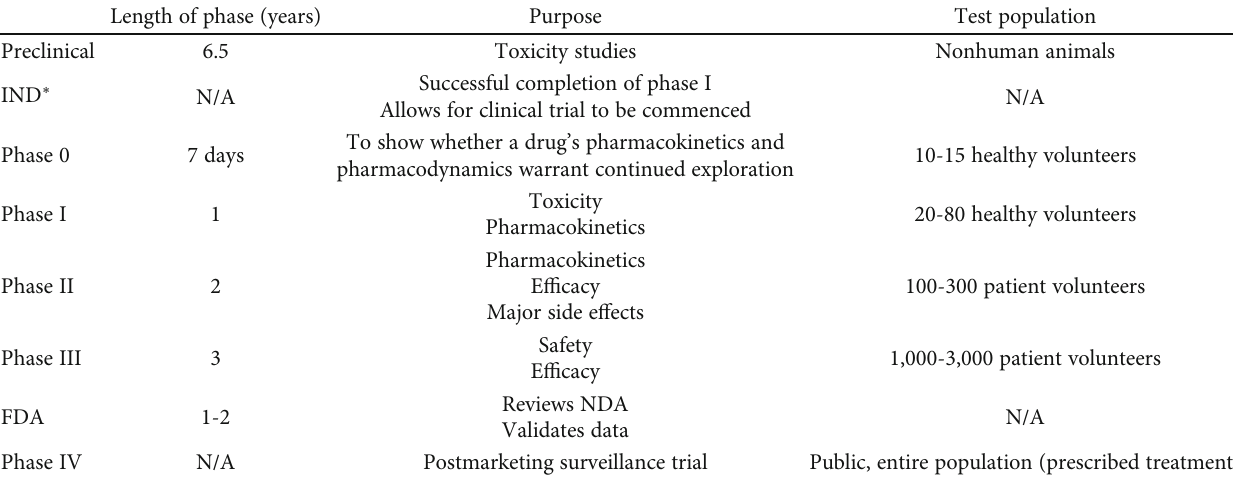
Figure 1: The challenges of treating CNS disorders. Both subjective and objective hurdles must be surpassed when developing pharmaceuticals for the treatment of CNS disorders and diseases. Overcoming these hurdles has proven di ffi cult leading to a minimum an increase in time and cost for drug development and at a worse to many drug failures that would otherwise be realized for a systemic- related disorder. Table 1: Clinical trial phases as regulated by the FDA. Table detailing FDA-regulated clinical trial phases as a function of their length, purpose, and test population. ∗ IND is not a distinct phase of the clinical trial process but is a required application between the preclinical phase and phases